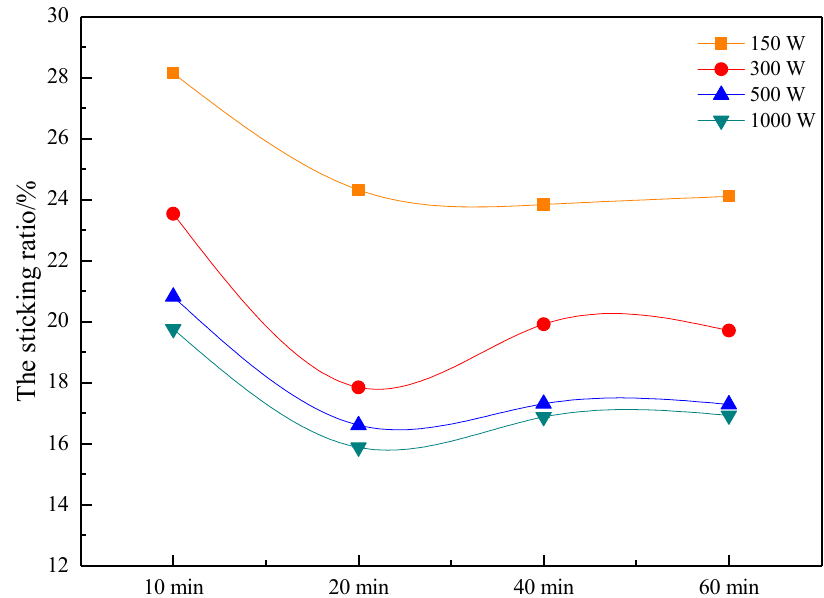
Figure 4. Changes of the metallization rate over time under different applied power. As can be observed from Figure 4, after the addition of the sound field, the metalli- zation rate of the Newman ore increased, but the increase was small, and a few samples even showed a decreased metallization rate. Moreover, the metallization rate of the Newman ore with different power sound fields showed fluctuations with respect to the ultrasonication time such that no meaningful systematic dependence on the ultrasonication time could be deduced from the data. Therefore, it can be concluded that the sound field had little effect on the metallization rate of the Newman ore.